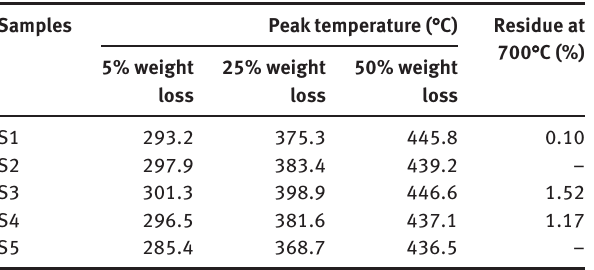
Table 3: The peak temperature at various percentages weight loss for the thermal degradation of non-hybridized and hybridized fiber composites obtained from thermal analysis.